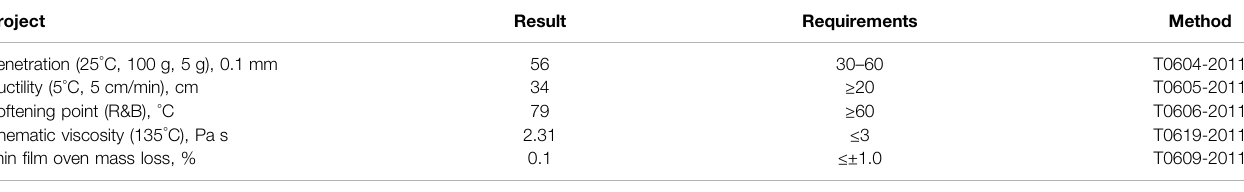
TABLE 1 | Test results of SBS (I-D) modi fi ed asphalt. Project Result